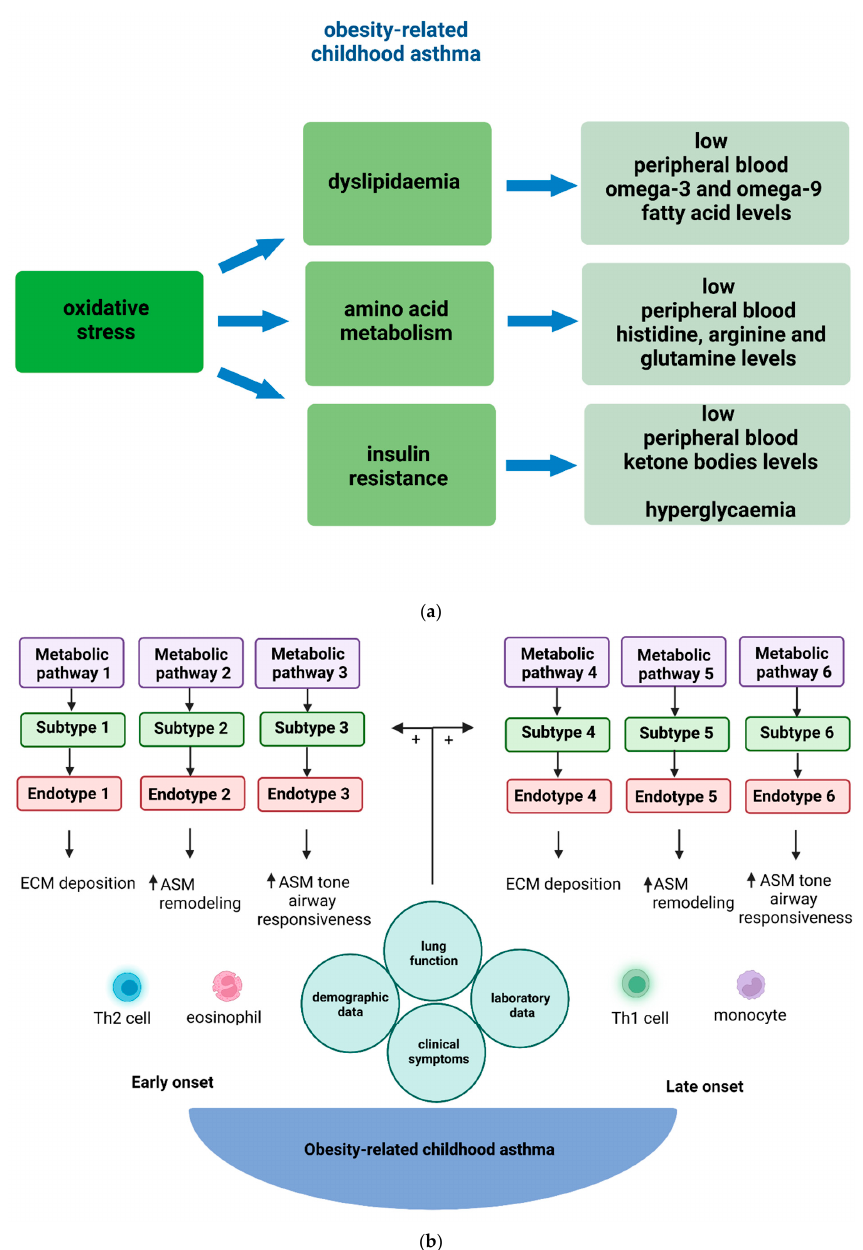
Figure 2. ( a ) Main metabolic profiles described as more prevalent in obese children with asthma in comparison to the control group (i.e., non-obese children with asthma). ( b ) The obesity-related childhood asthma phenotype consists of various endotypes. In children, early onset of obesity-related asthma is usually associated with T H 2-high inflammation, whilst late onset of obesity-related asthma is associated with T H 2-low inflammation. Metabolic dysregulation contributes to both T H 2-high and T H 2-low systemic and airway inflammation that underlies ECM deposition, ASM proliferation, related airway tissue remodeling, and airway reactivity in obesity-related asthma endotypes in chil- dren. Metabolomic pathways, identified by metabolomic strategies, provide further insight into the pathogenetic mechanisms underlying these diverse endotypes. Subtypes of obesity-related childhood asthma derive through the combination of clinical information with endotypic characterization data. Obesity-related asthma subtypes refer to groups of children with common clinical characteristics and endo-metabotypes (meaning a subtype of an endotype described by similar metabolic dysregulation mechanisms). Abbreviations: ASM: Airway smooth muscle, ECM: Extracellular matrix, T H 2: T helper